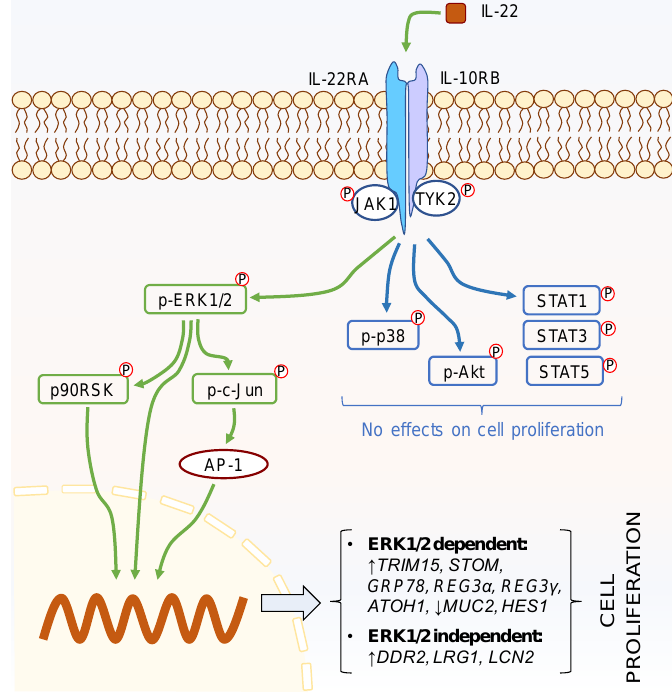
Figure 8. IL-22-induced modulation of intestinal epithelial cell proliferation is dominated by the ERK1/2 pathway. Green arrows indicate possible mechanism(s) of IL-22, where blue arrows show no effects on cell proliferation.